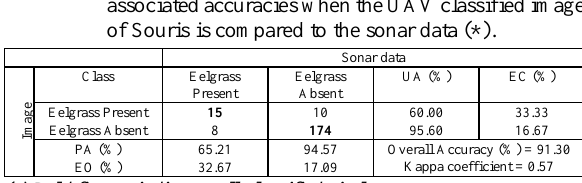
Figure 6. Classified image produced by applying the RF classifier to the reflectance band images, associated vegetation indices, and bathymetric ratios to the UAV image of Richibucto for a) Site 4, b) site 5, and c) Site 6.